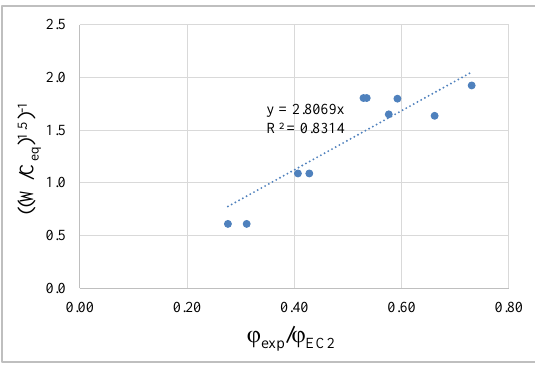
Figure 9. Correlation between W/Ceq ratio and Exp/EC2 relationship of creep coefficients. Knowing that the amplitude of the creep curves strongly depends on the β (f cm ) coe ffi cient, Equation (9), the result of the correlation obtained was incorporated in determining this coe ffi cient. Due to the verified dispersion, the amplitude of the correlation was reduced in order to